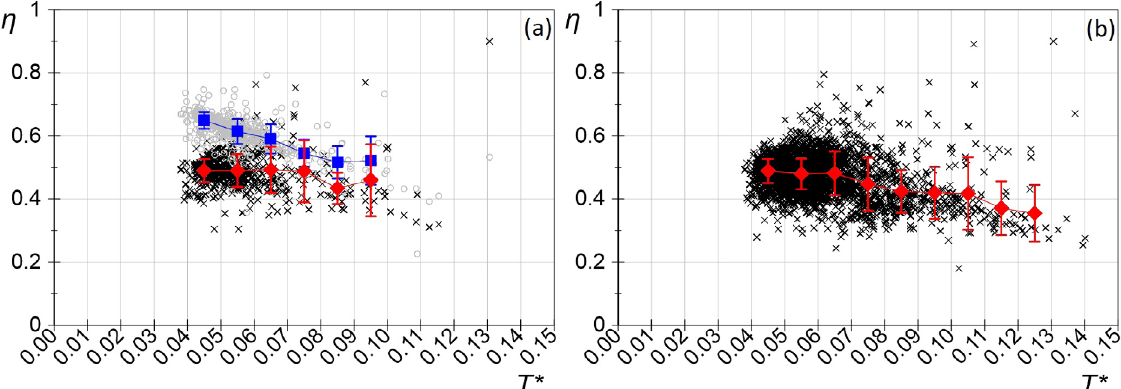
Fig. 3. Solar fi eld ef fi ciency as a function of the reduced temperature. Left panel (a): July 2014. Right panel (b): entire 2014. Grey circles: quasi-dynamic model calculated for the experimental operating conditions. Blue squares: bin averages of quasi-dynamic data. Black crosses: experimental data. Red diamonds: bin averages of experimental data. Bars: standard deviation within